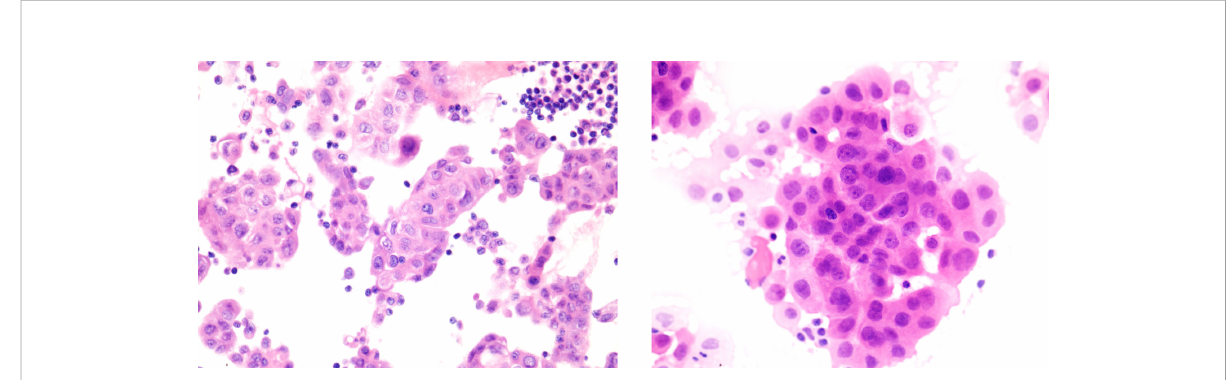
FIGURE 4 Histopathological fi ndings of pituitary metastases. IHC yielded the following: PCK (+), TTF-1 (+), NapsinA (+), EMA (+), Syn (partial +), CgA (focal +), GFAP ( – ), S1001 (-), CD68 (-), CD34 (-), ACTH (-), GH (-), PRL (-), FSH (-), LH (-), TSH (-), Ki67